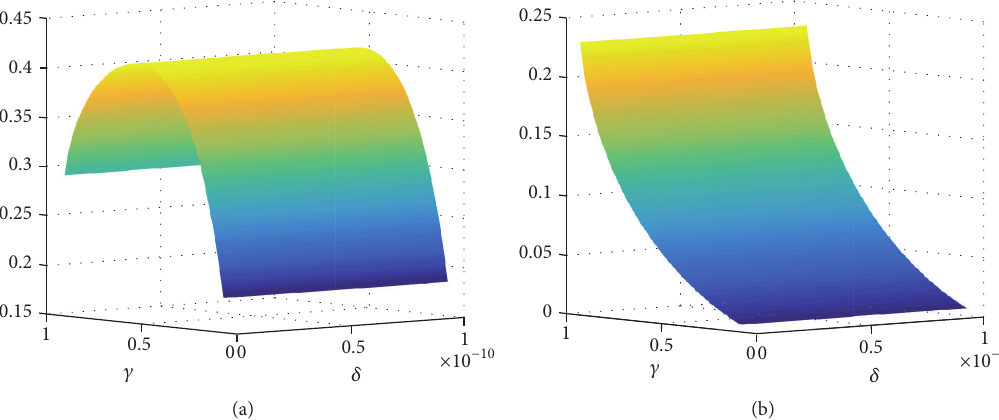
Figure 6: In this figure, we plot (a) 𝑀 𝛿 (𝑝 1 𝛾 ; 𝛾) and (b) 𝑀 𝛿 (𝑝 2 𝛾 ; 𝛾) over the range 10 −12 ≤ 𝛿 ≤ 10 −10 and 0.1𝛾 ∗ ≤ 𝛾 ≤ 0.99𝛾 ∗ .